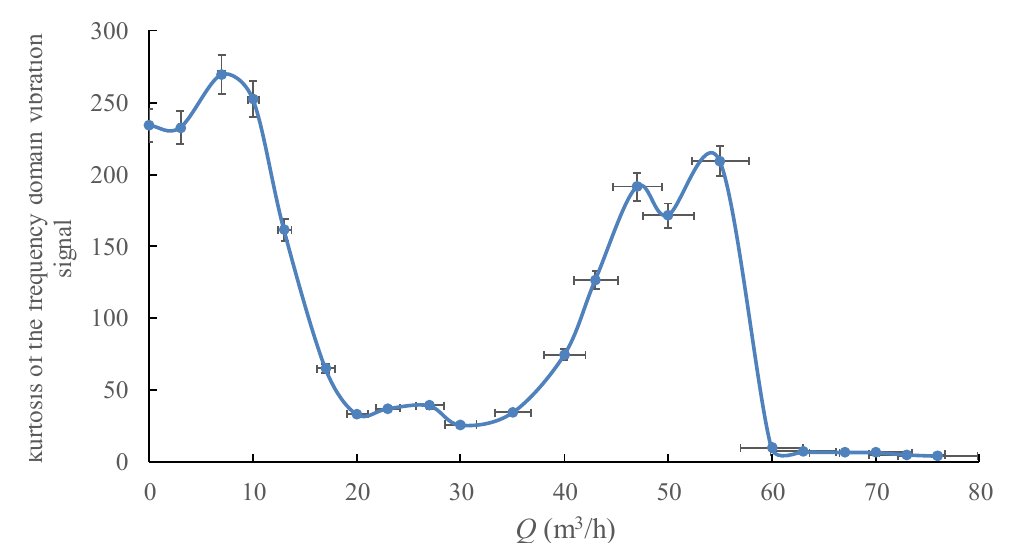
Figure 15. Crest factor for the frequency domain vibration signal under different flowrates.